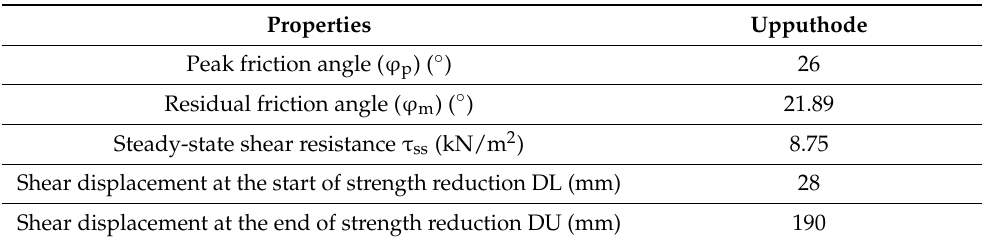
Table 2. Properties used in the simulation.